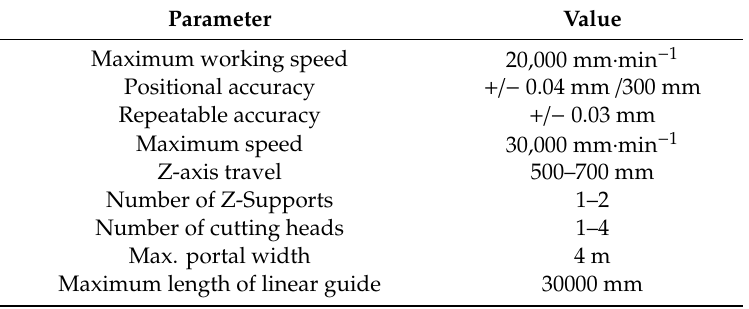
Table 1. Technical parameters of the coordinate table WJ4020 1Z-C0-PJ60